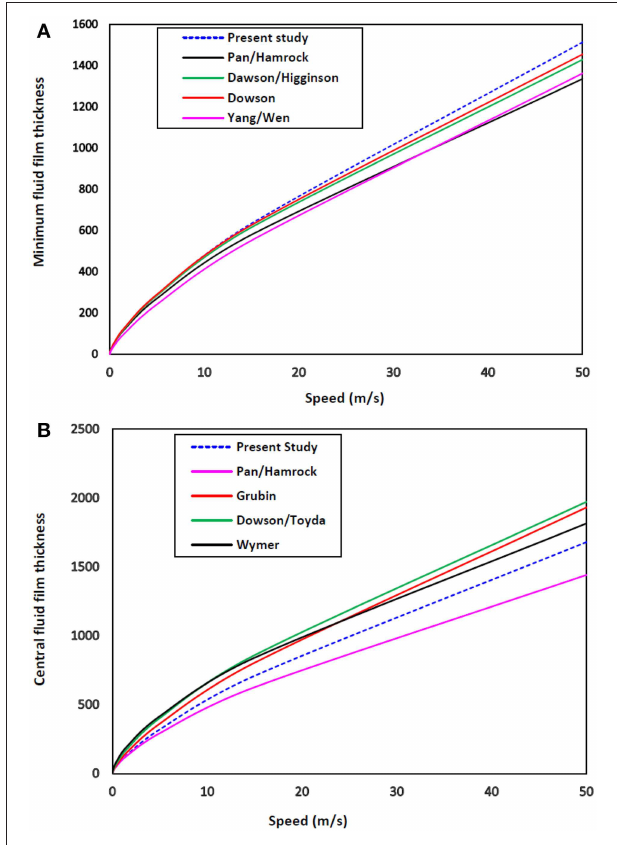
FIGURE 5 | Comparison with the results from classic EHL line-contact film thickness formulas: (A) minimum film thickness, and (B) central film